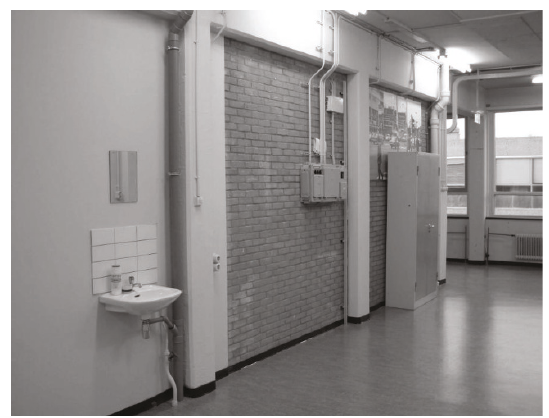
Figure 1: Photograph of the corridor